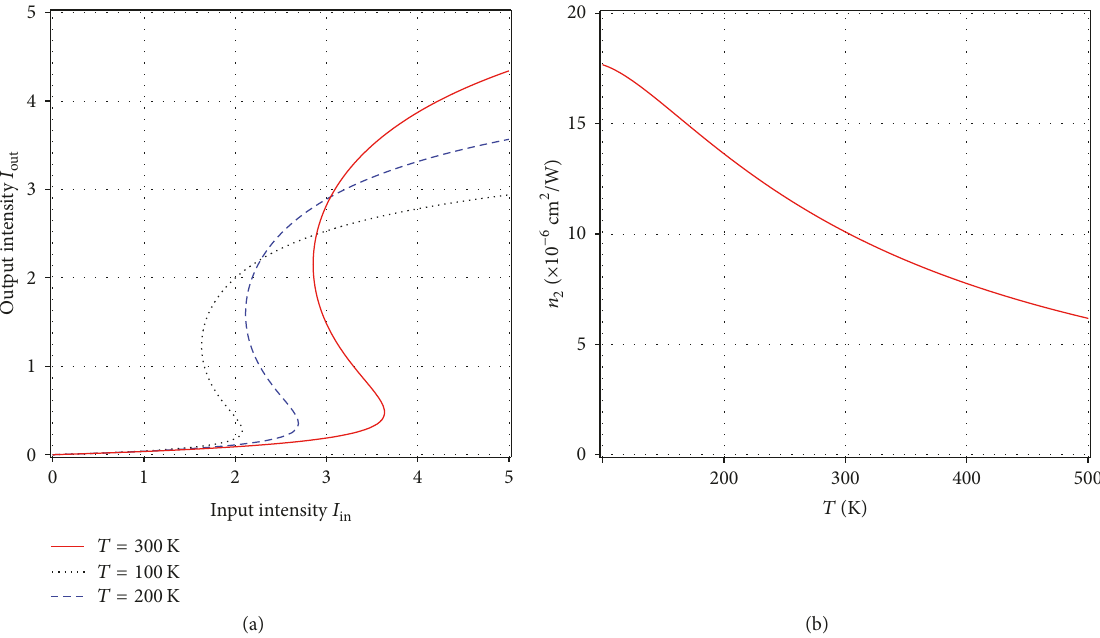
Figure 5: The OB curves at particular values of the temperature (a) and variation of Kerr nonlinear coefficient 𝑛 2 versus the temperature (b). The parameters are Δ 𝑝 = −5 MHz, Δ 𝑐 = 0 , and Ω 𝑐 = 70